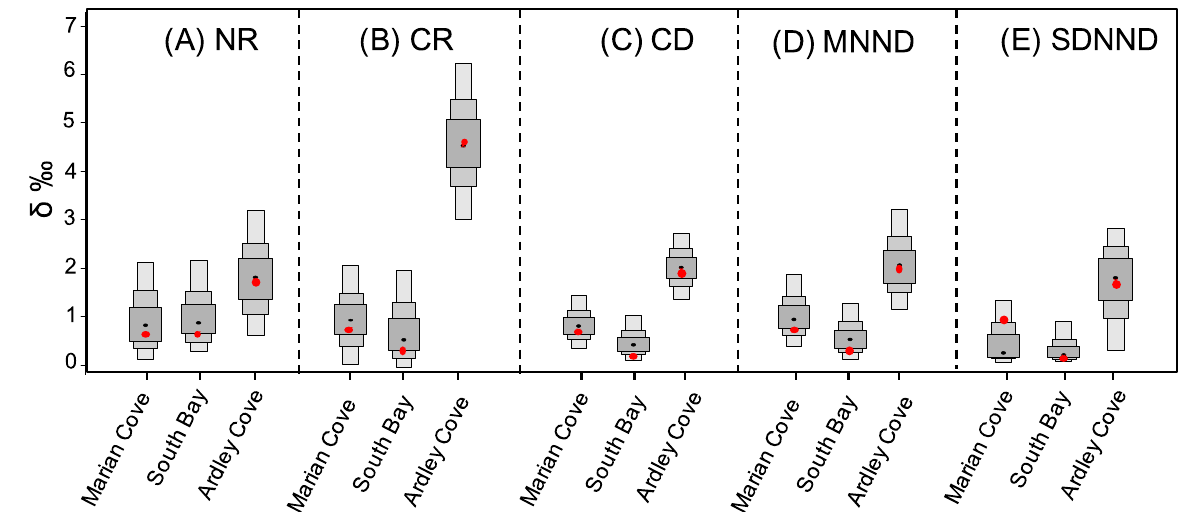
Figure 3. In the left panel, ( A ) solid lines enclose the standard ellipse areas corrected for the sample size (SEAc) of O. validus populations from Ardley Cove, Marian Cove and South Bay. The right panel ( B ) shows the standard ellipse area Bayesian estimations (SEAB) for each population. Black dots show the SEAB mode, red dots represent the SEAC, and gray boxes the probability of data distribution (50% dark grey boxes, 75% light grey boxes and 95% lighter grey boxes).